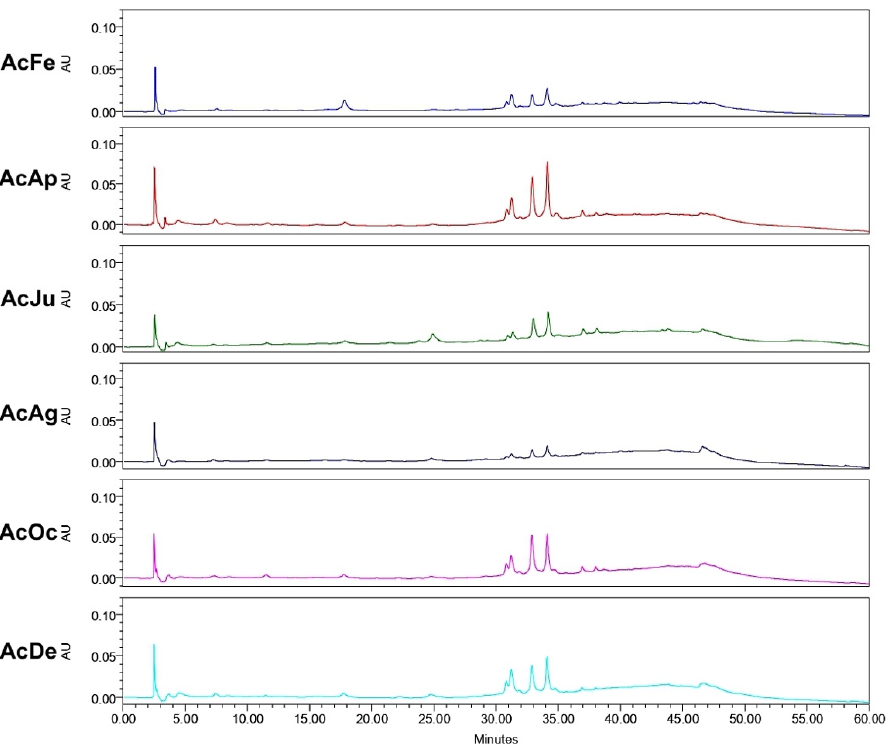
Figure 5. UV spectrum obtained from HPLC-DAD analysis of rutin ( A ), nicotiflorin ( B ), and nar- cissin ( C ).